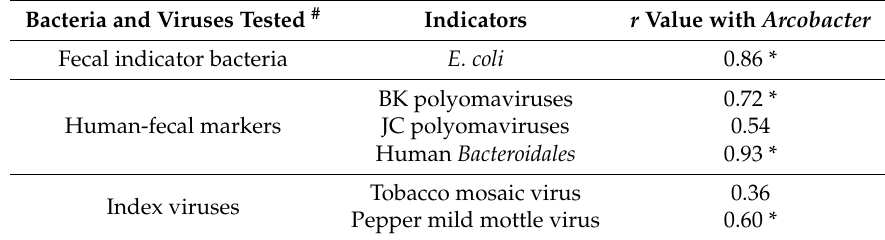
Table 2. Relationships of fecal indicator bacteria, human-fecal markers, and index viruses with Arcobacter